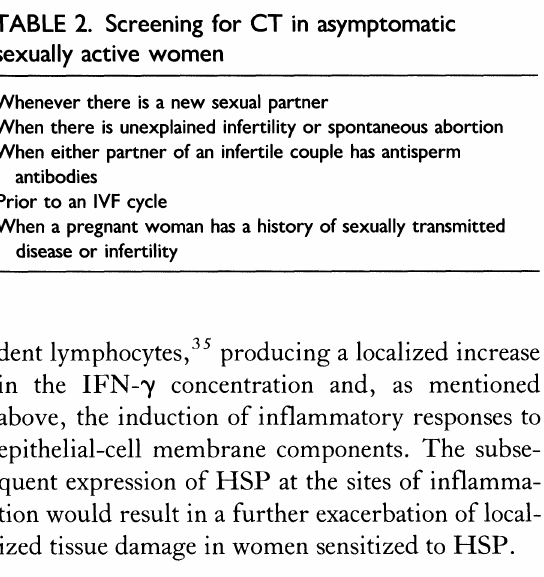
TABLE 2. Screening for CT in asymptomatic sexually active